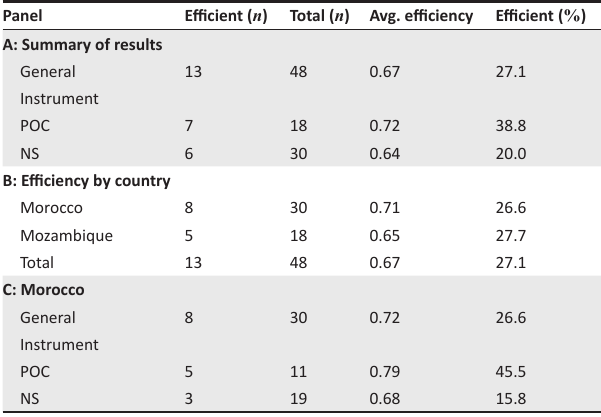
TABLE 7: Instrument efficiency: General model (Inputs: salaries and purchases). Panel